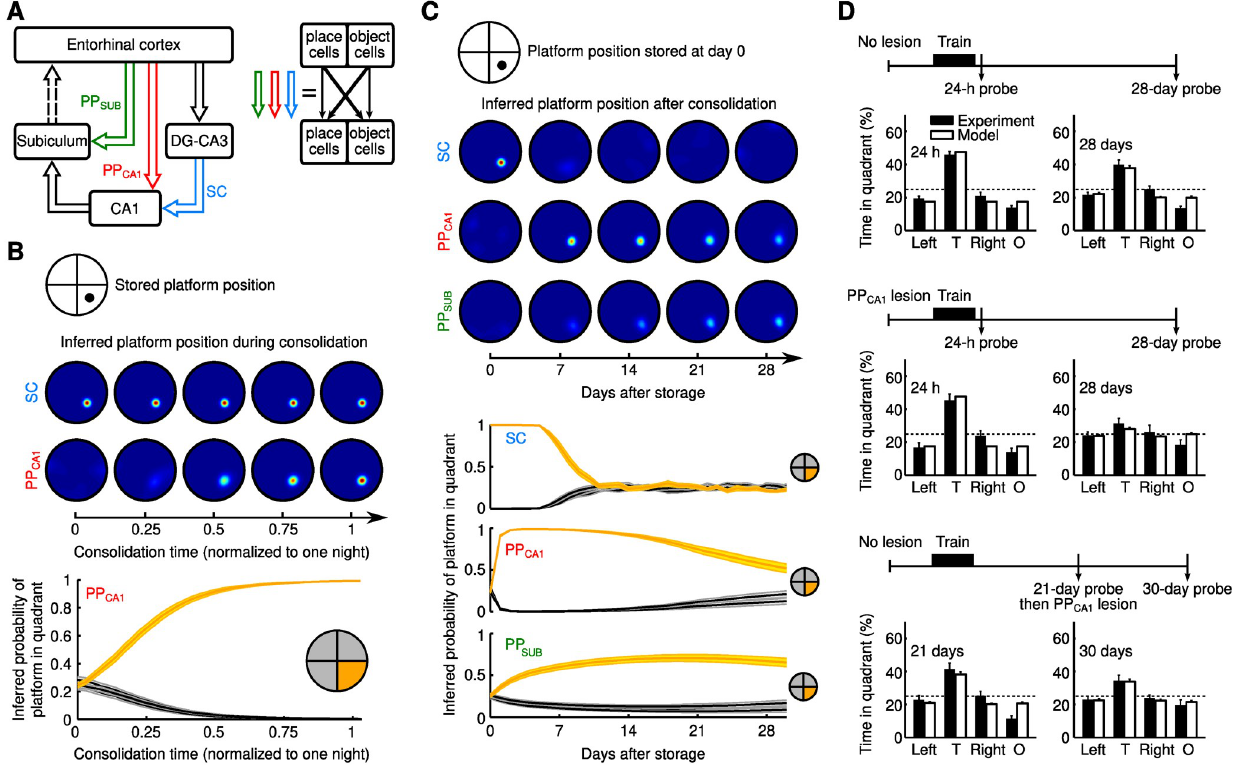
Fig 4. Consolidation of place-object associations in multiple hippocampal stages. (A) Structure of the extended model. PP SUB : perforant path to the subiculum. Each area (EC, DG-CA3, CA1, SUB) contains object-coding and place-coding populations. Open arrows: all-to-all connections between these areas. (B) Decoding of consolidated associations. Top: The location of a platform in a circular environment is stored as an object-place association in the SC (thick diagonal arrows in A, right). Middle: Platform position probability maps given the platform object cue, inferred from the CA1 output resulting from SC or PP CA1 alone, at different times during consolidation (see section “Consolidation of place-object associations in multiple hippocampal stages” in Methods). Bottom: Platform-in-quadrant probabilities ( ± SEM) given PP CA1 input alone during consolidation. Quadrant with correct platform position (target quadrant) in orange. (C) Consolidation from SC to PP CA1 and to PP SUB over four weeks. Each day, a new association is first stored in SC and then partially consolidated. An association on day 0 is monitored in SC, PP CA1 , and PP SUB . Panels as in B. (D) Effects of PP CA1 lesions on memory consolidation, model and experiment (data with permission from [27]). Histograms of time ( ± SEM) spent in quadrants at different delays after memory acquisition (“probe”). Dashed lines at 25% are chance levels. T: target quadrant; Left, Right: adjacent quadrants; O: opposite quadrant. Top: Control without lesion. Middle: Lesion before memory acquisition. Bottom: Lesion 21 days after memory